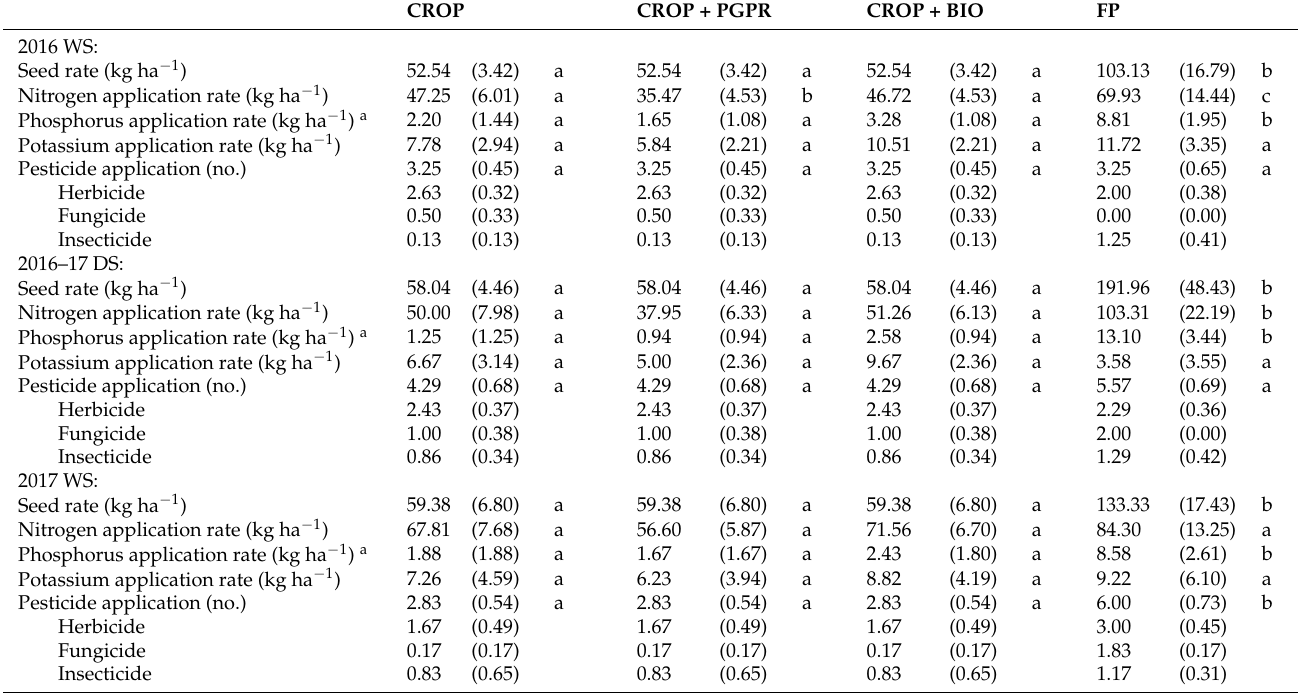
Table 6). Table 3. Key inputs (mean values followed by standard error in parenthesis) of rice production across four field trial treatments over three